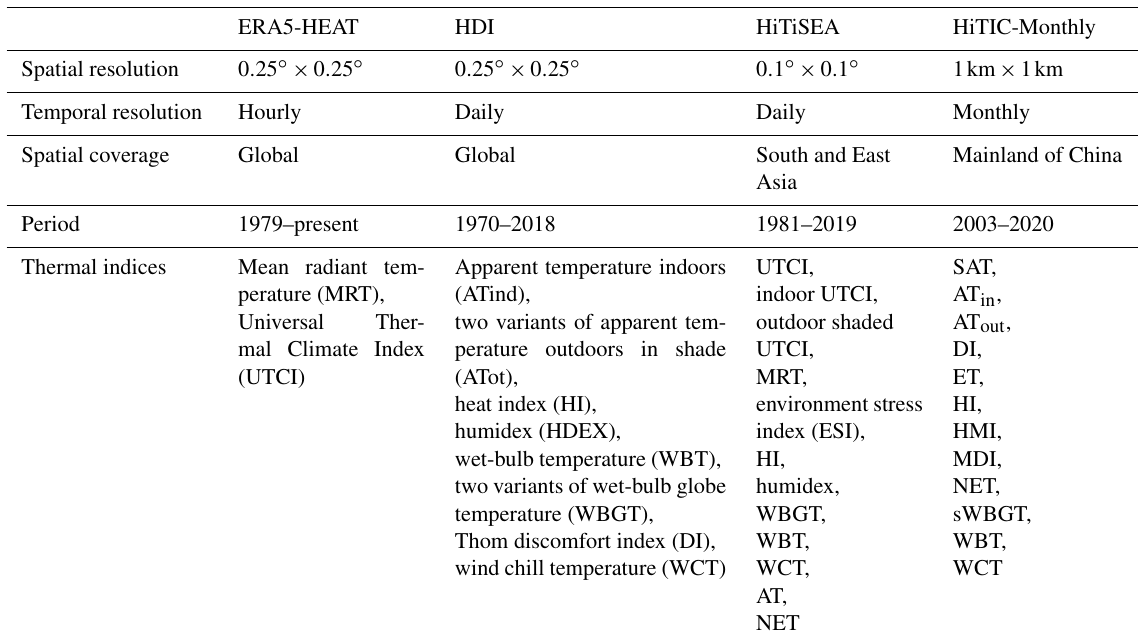
Figure 13. Temporal trends of the 12 annually and seasonally averaged human thermal indices over the mainland of China during 2003– 2020. The number means linear trend per decade. The asterisk indicates that the trends are significant at the 0.05 level. Table 4. Comparisons of the four thermal index